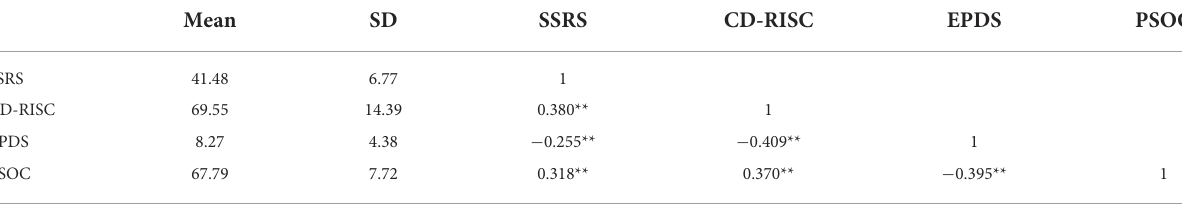
TABLE 2 Correlation for all variables (N = 234).